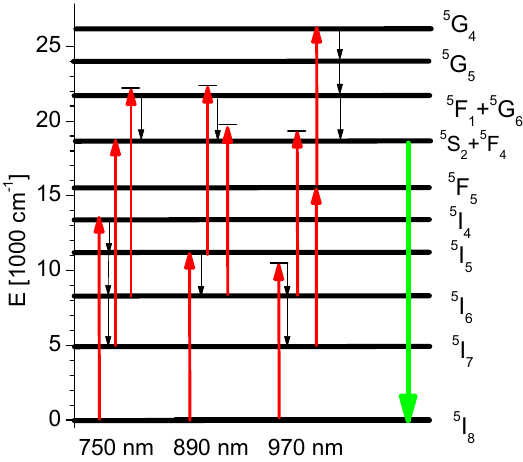
Figure 7. Spectrum of calculated ground state absorption (GSA) and excited state absorption (ESA) integrated cross sections σ in SrLaGaO 4 :Ho 3+ crystal.